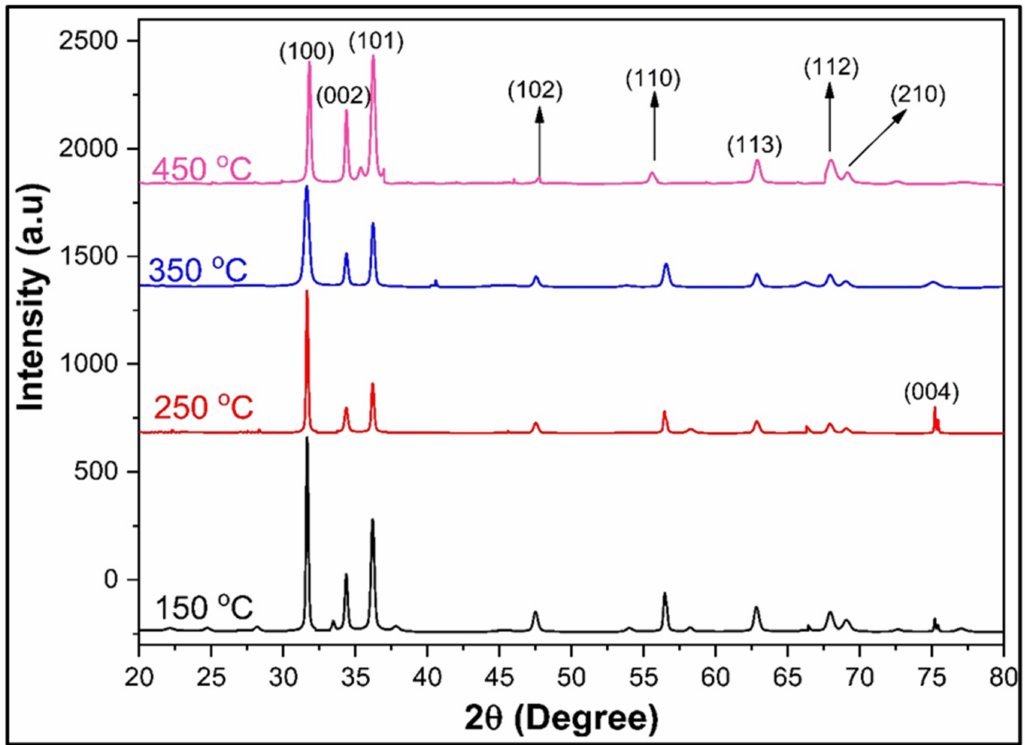
Figure 7. The XRD patterns of ZnO nanoparticles synthesized by using a green method and the leaf extract of the thyme plant at different calcination